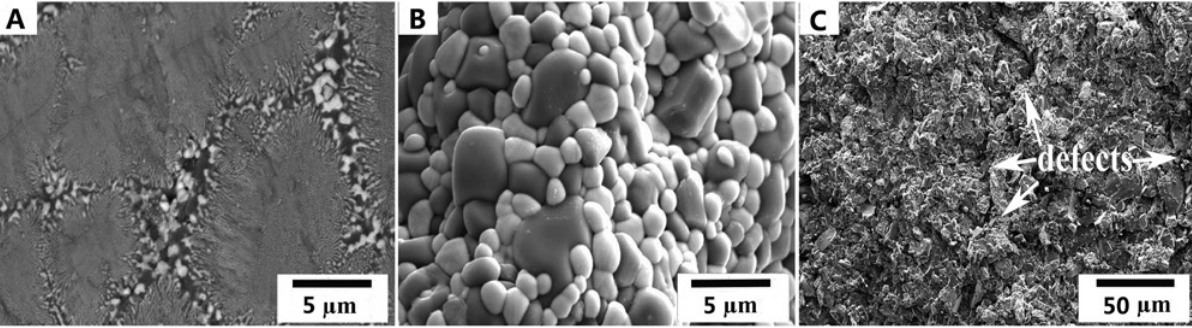
Figure 2 SEM photographs of (A) AZ40 starting material, (B) AZ40 after 3 h at 1650 ° C, (C) the sample with AZ40